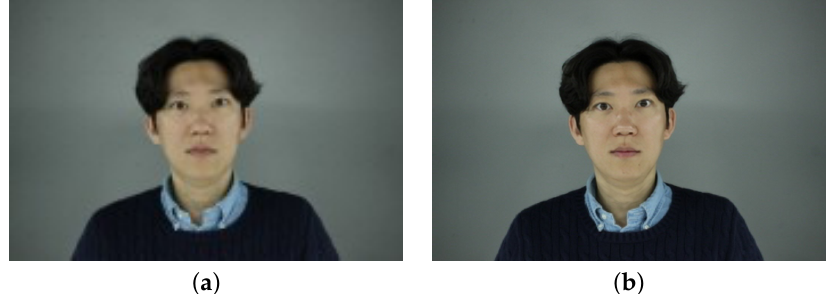
Figure 3. Example of the result of super resolution: ( a ) low-resolution input images; ( b ) result of super